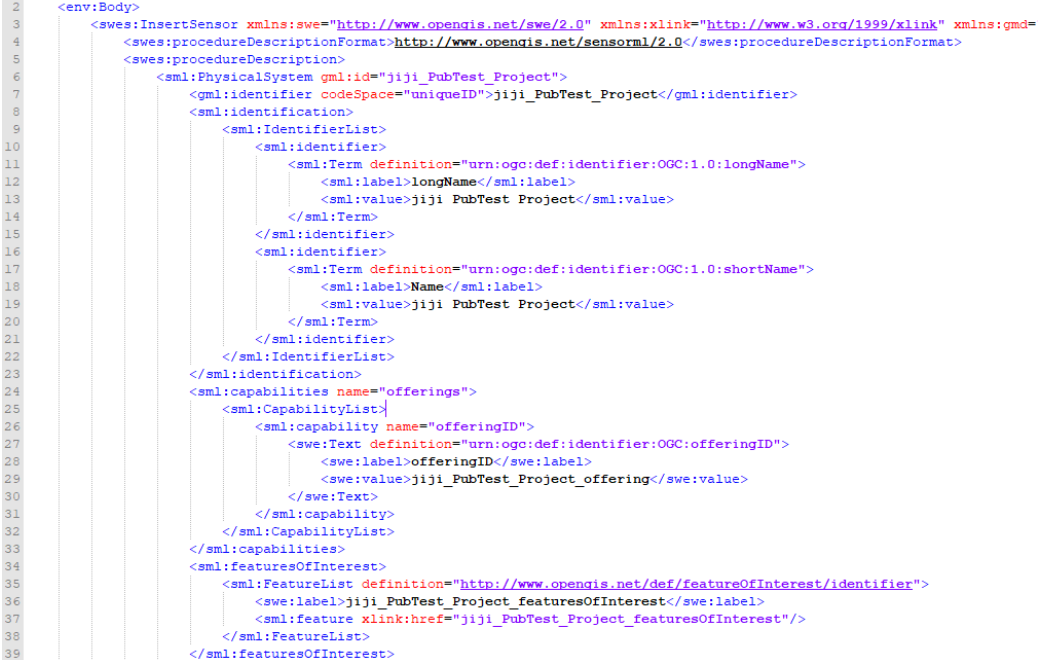
Figure 8. Insert sensor Extensible Markup Language (XML) request, InsertSensor_identifier, offering, and featuresOfInterest.